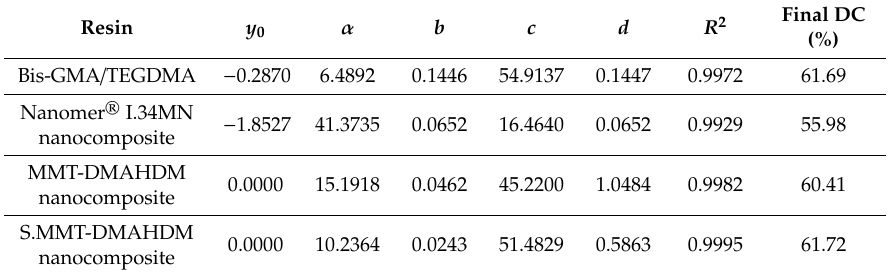
Table 3. Parmeters describing the exponential sum function accompanied by the coe ffi cient of deterimination, R2, and the calculated values of the final percent degree of conversion (DC (%)).